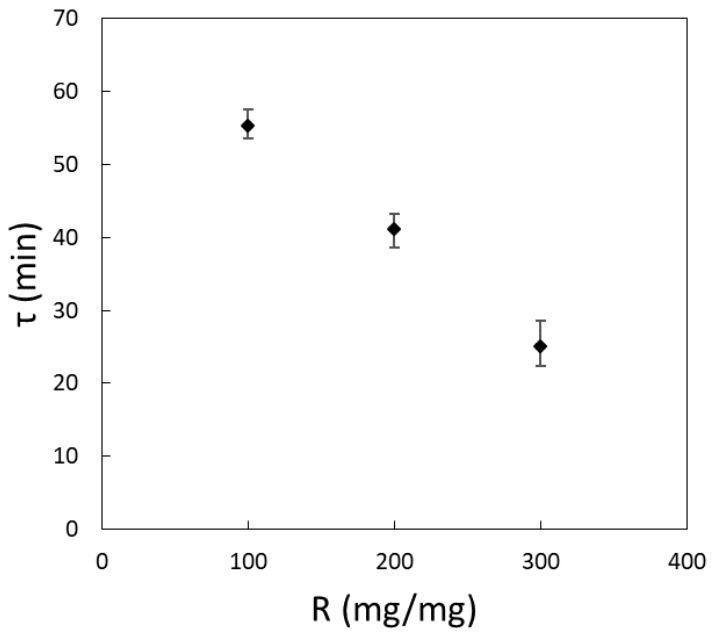
Figure 9. Variation in the characteristic time of adsorption of methylene blue using yerba mate versus R. The points reported are the means of the fitting values. Moreover, the error bars represent the maximum and minimum difference between the values of fitting and the mean.